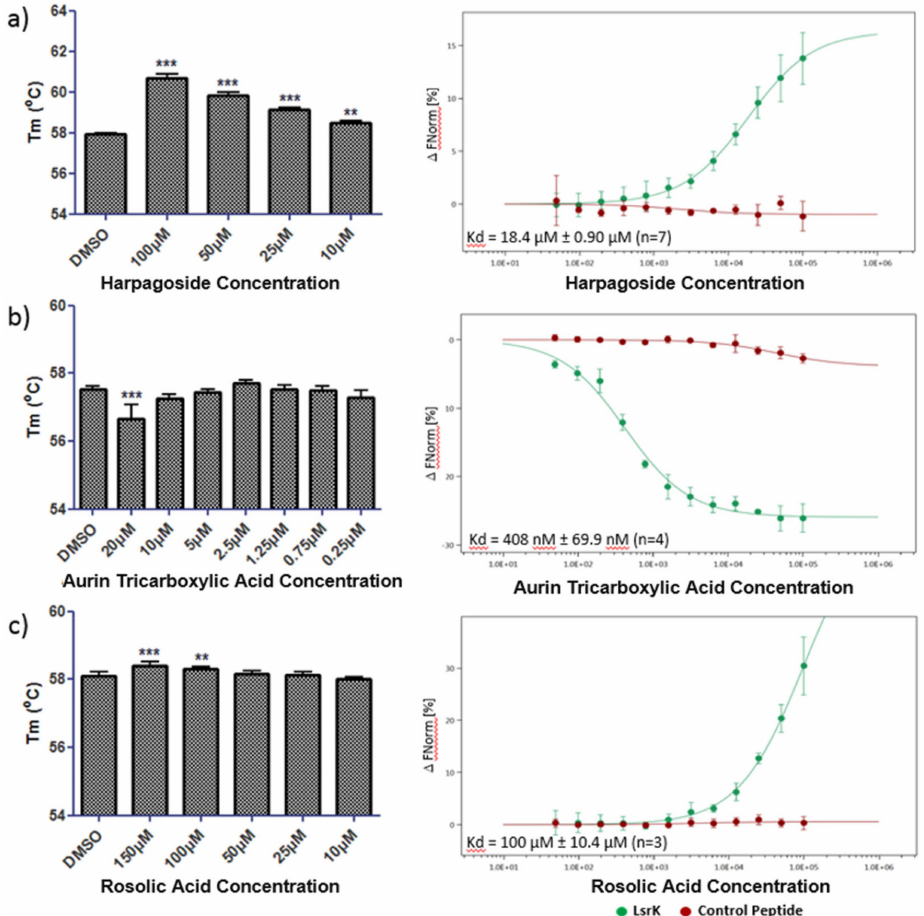
Figure 5. Melting temperature ( T m ) for LsrK protein (1 µ g / well) in the presence of 1% DMSO or a dose range of test compound ( left hand panels) where experiments performed n = 3 for harpagoside ( a ), n = 4 for aurin tricarboxylic acid ( b ) and n = 5 for rosolic acid ( c ). Changes in thermophoretic movement for dye labelled His-LsrK protein or His-Control peptide in response to test compounds ( right hand panels) where experiments performed n = 7 for harpagoside, n = 4 for aurin tricarboxylic acid and n = 3 for rosolic